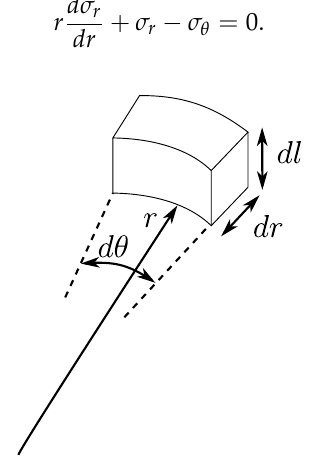
Figure 4. Small volume of a